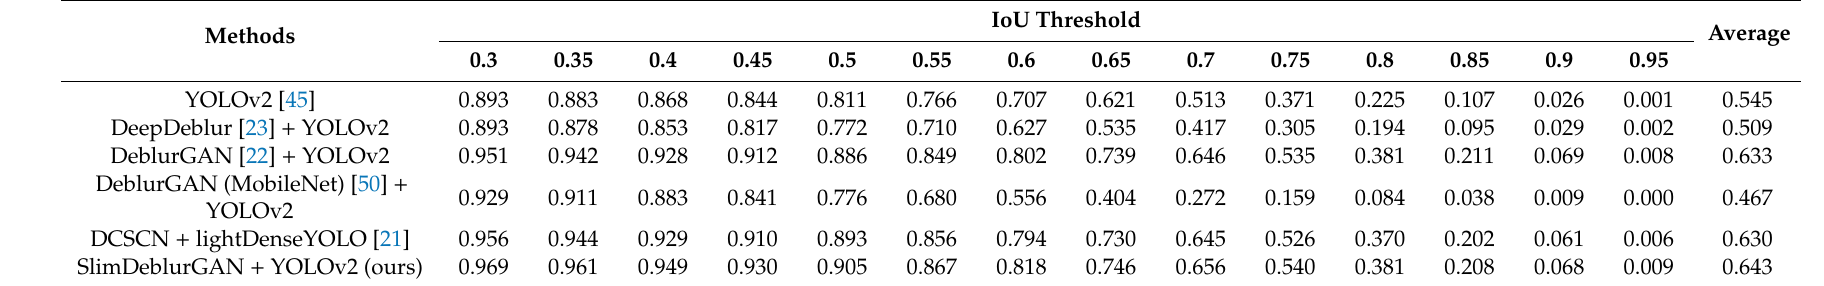
Table 11. Comparisons of the F1 Score on